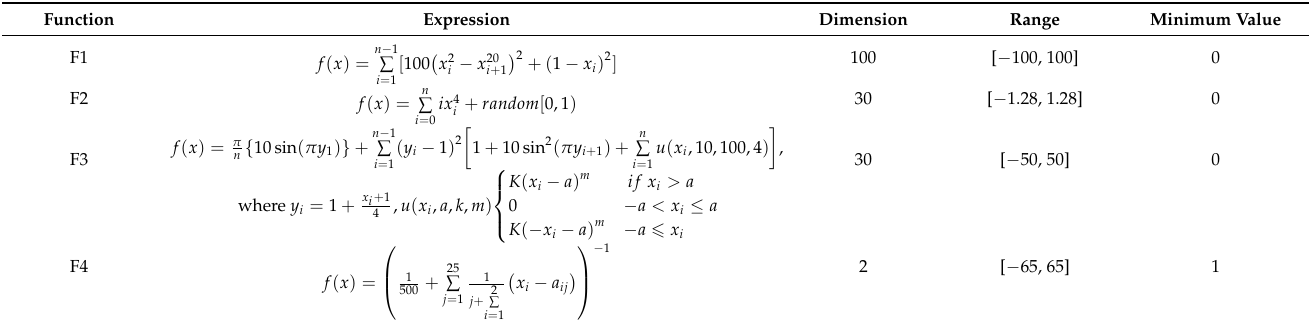
Table 1. Benchmark